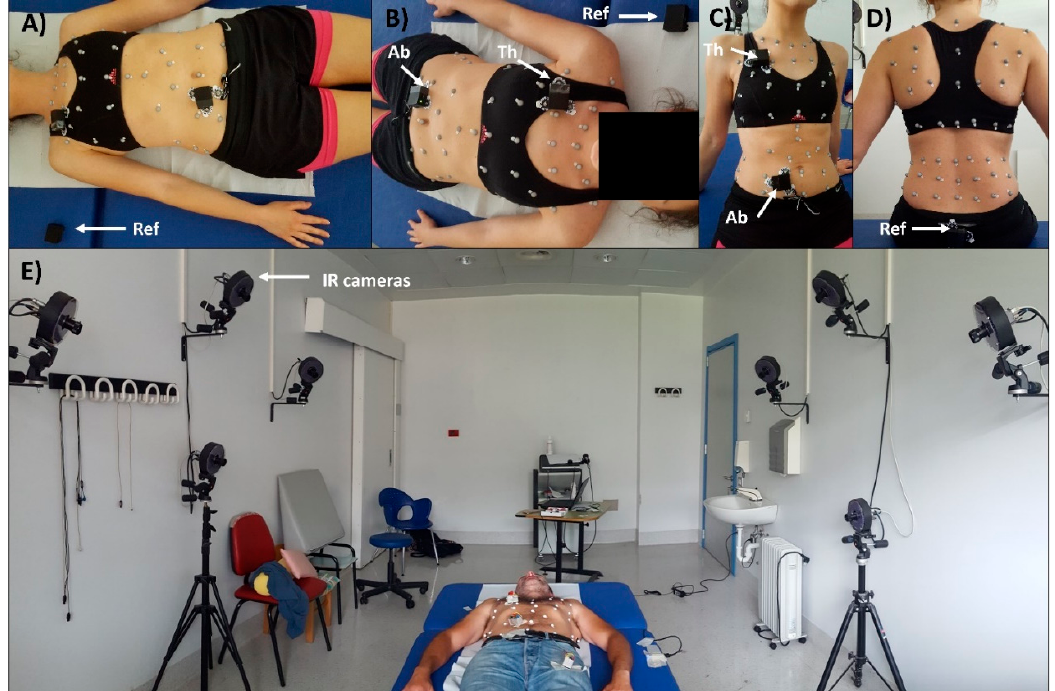
Figure 3. Experimental setup. Retroreflective-marker configuration for optoelectronic plethysmography (OEP) and IMU-unit (Ab: Abdomen, Th: Thorax, Ref: Reference) placement in supine (A and B panels) and seated (C and D panels) positions. Panel E shows the experimental setup and the OEP Lab; Infrared cameras of the motion capture system are also noticeable.